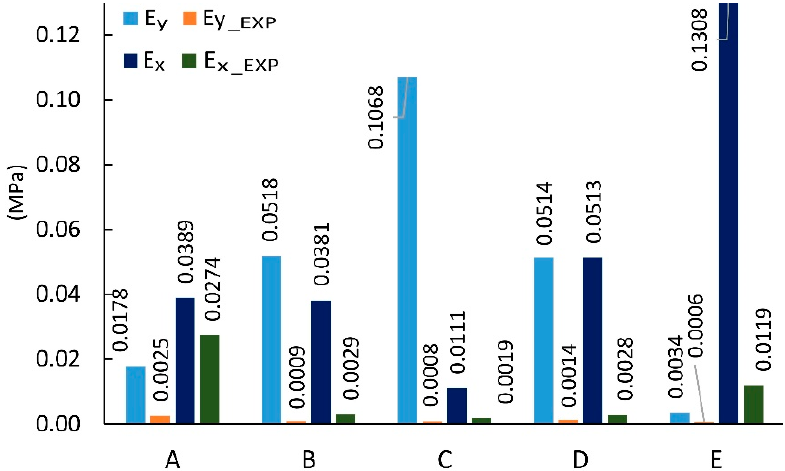
Figure 9. Modulus of linear elasticity for cells of the type: A, B, C, D, E (EXP-experimental research).